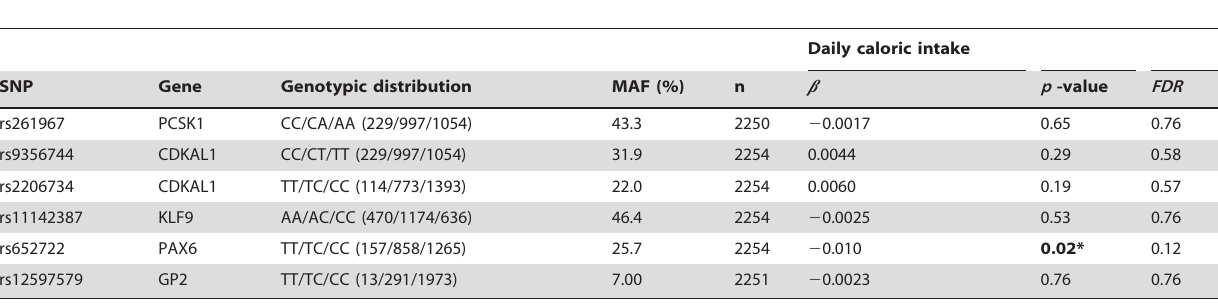
Table 3. Analysis of association of rs652722 with daily caloric intake in the Greek